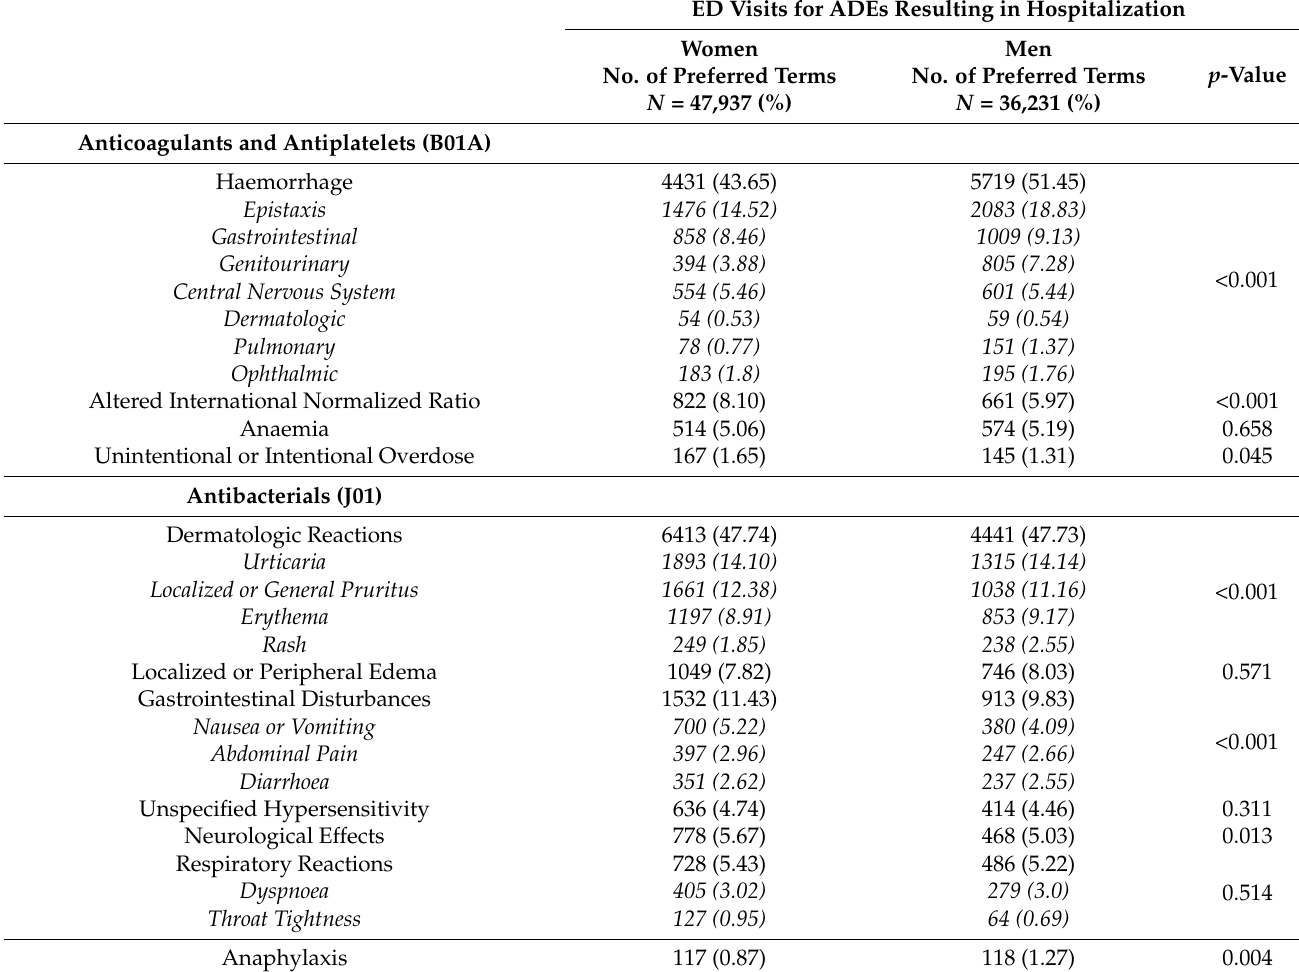
Table 4. Adverse events manifestation by most commonly reported suspected drug classes.